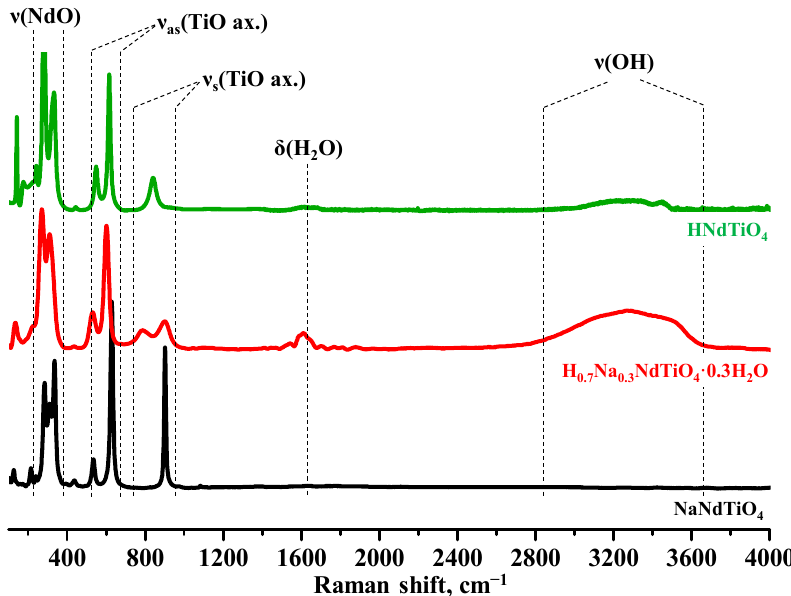
Figure 9. Raman spectra of the HNdTiO 4 , H 0.7 Na 0.3 NdTiO 4 ·0.3H 2 O and NaNdTiO 4 samples.